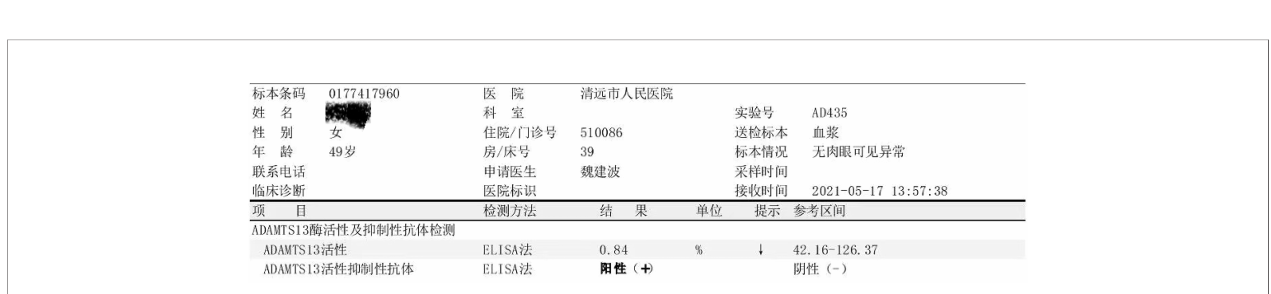
FIGURE 2 | The result of ADAMTS13 autoantibodies and ADAMTS13 inhibitory